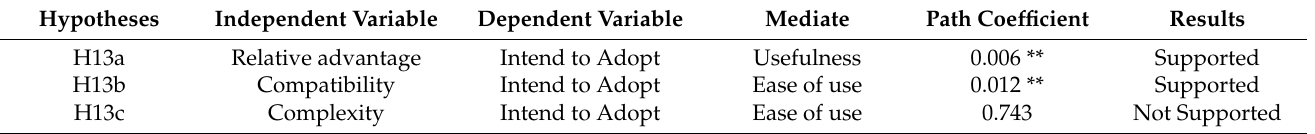
Table 5. Hypothesis tests for the mediating effects.